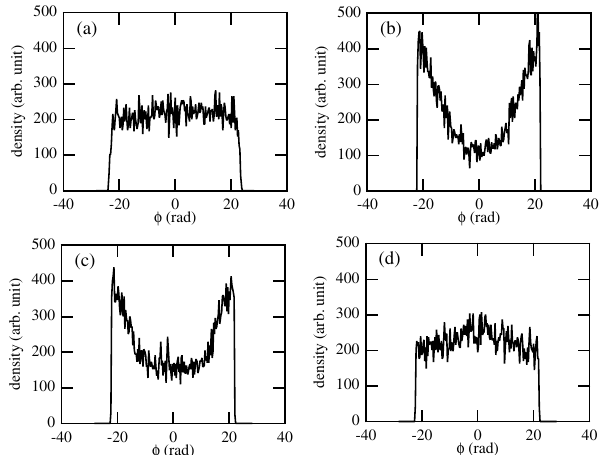
FIG. 8. Density distribution of a superbunch beam in the (cid:23) direction at (a) injection, (b) 4.69 GeV, (c) 6.69 GeV, and (cid:4) 7 (cid:14) (rad) and k (cid:4) (cid:5) 0 : 43 (cid:1) kV =(cid:22) s (cid:2) . (d) 11.64 GeV. (cid:23) 0